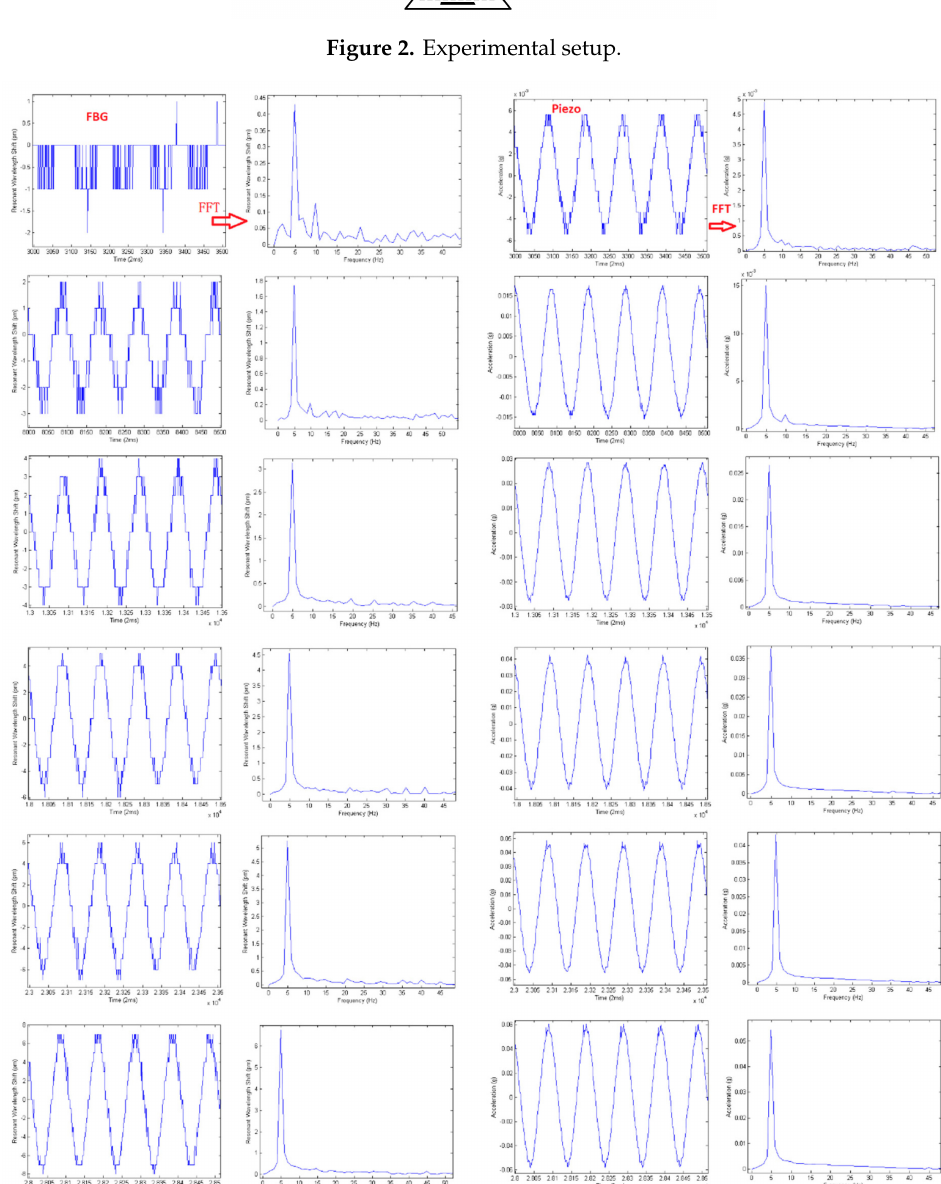
Figure 3. Experimental